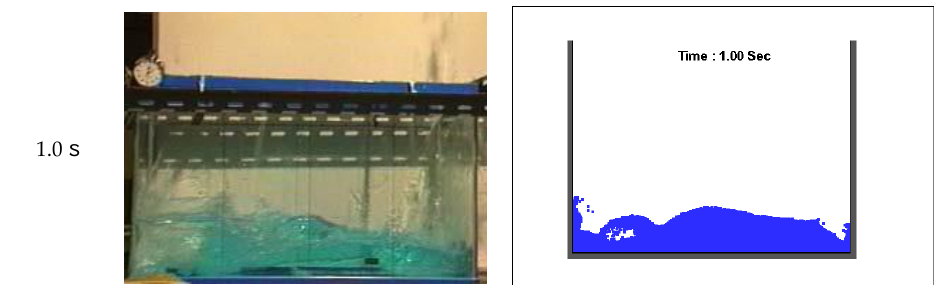
Figure 3. Evolution of the collapsed water column.